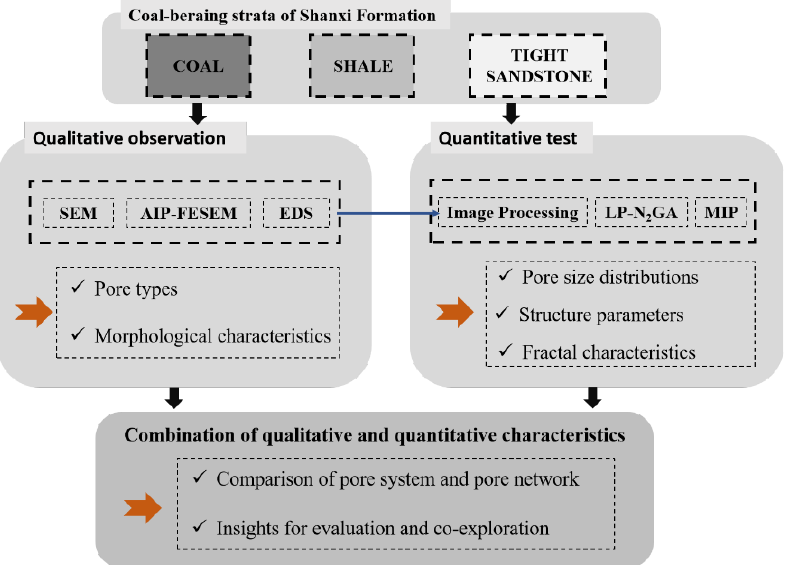
Figure 3. Comparison of pore systems of three types of unconventional reservoirs in coal-bearing strata.